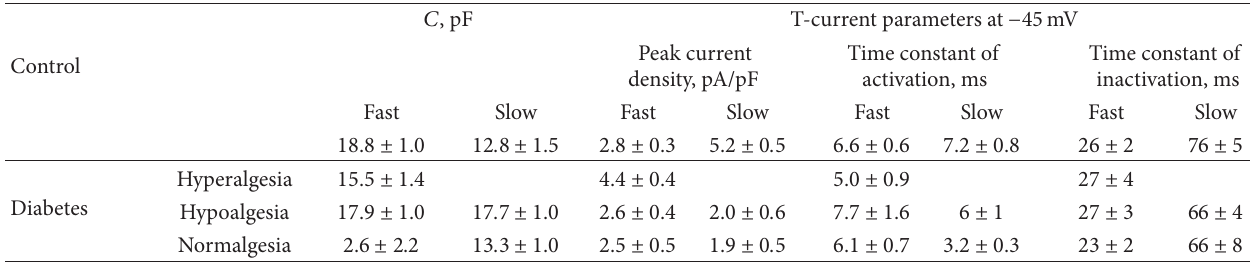
Table 1: Parameters of fast and slow T-currents in NTCN